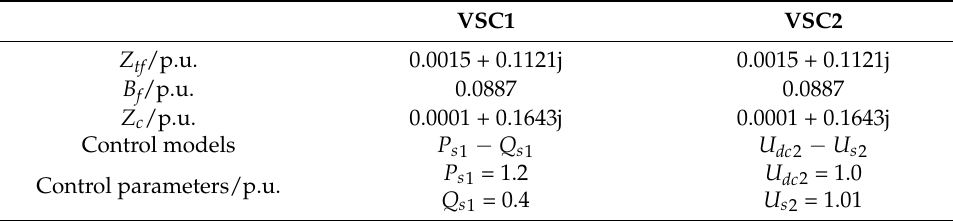
Table 1. The parameters of converter stations.